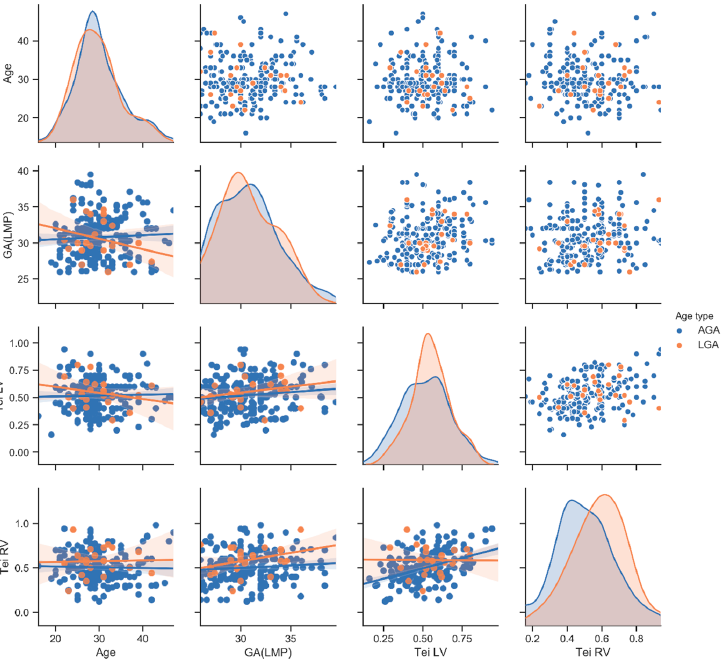
Figure 4. Correlogram of Tei LV, Tei RV, maternal age and gestational age in LGA presented in red dots ( n = 25) and AGA presented in blue dots ( n = 263), studied fetuses visualized with pair-plots in Python. A pair-plot allows one to observe both distribution of single variables and relationship between two variables. For more explanation, see statistical analysis in this article [5,6].